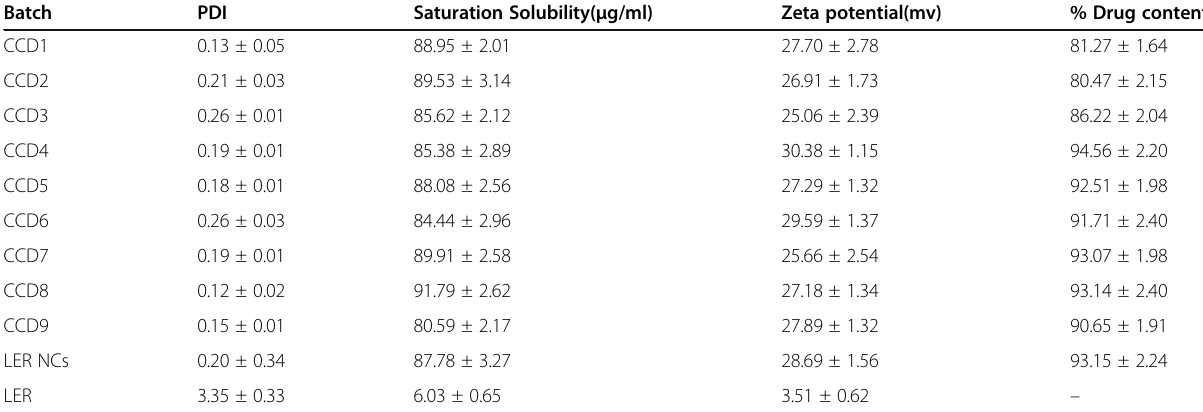
Table 2 PDI, zeta potential, saturation solubility, and drug content results